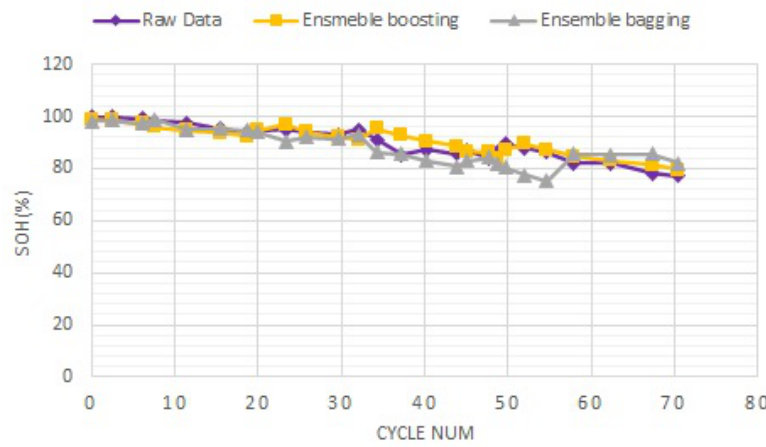
Figure 8. The predicted results of SOH estimation on battery 6 of the battery dataset.